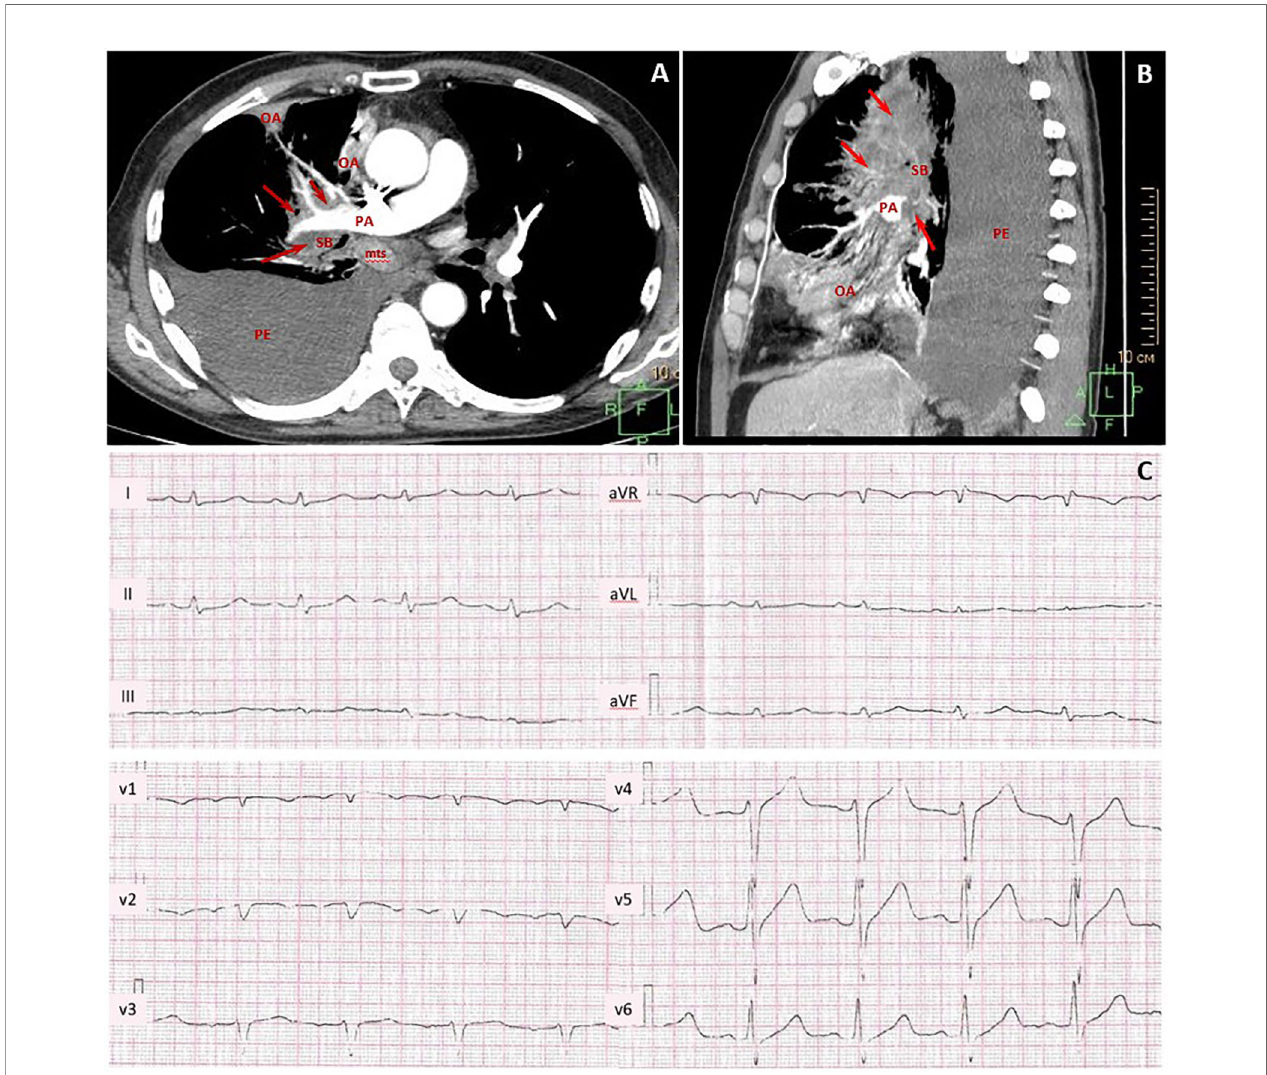
FIGURE 2 | Contrast-enhanced chest CT scans and pretreatment electrocardiogram. CT maximum intensity projection reconstruction (A) axial plane and (B) sagittal plane: massive lung tumor with right pulmonary artery, pulmonary veins, lobar and segmental bronchi involvement (red arrows, tumor; PA, pulmonary artery; SB, segmental bronchus; OA, obstructive atelectasis; mts, bifurcation lymph node metastasis; PE, large right-sided pleural effusion). (C) Pretreatment ECG with sinus tachycardia, incomplete right bundle branch block, and poor progression of R-wave in V1 – V3